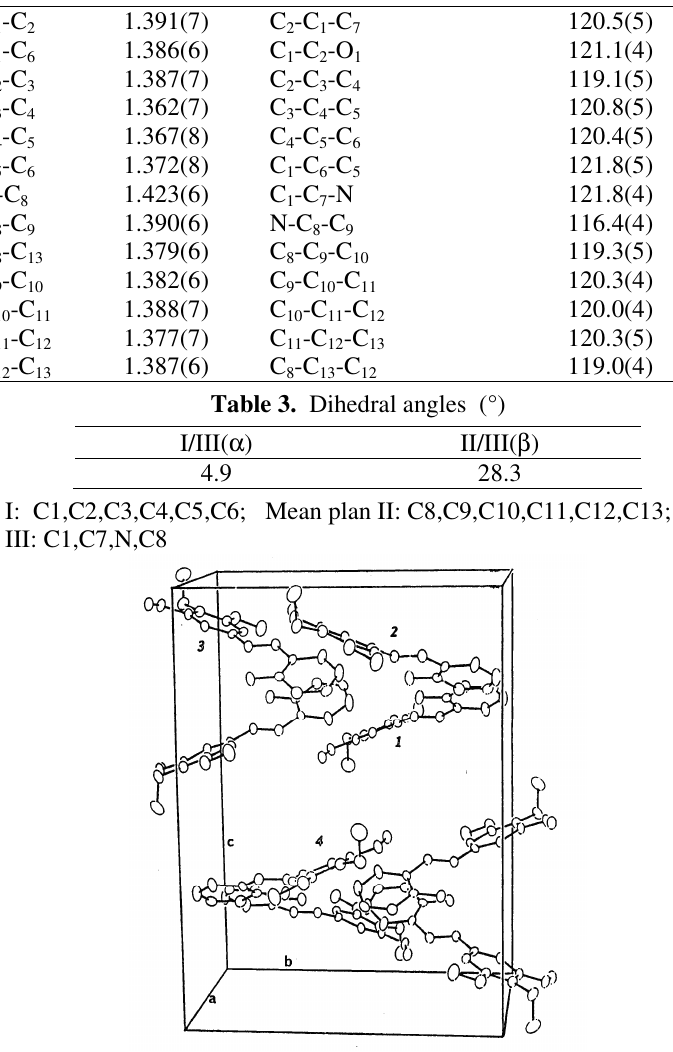
Table 2. Selected bond lengths and angles (Å, °).